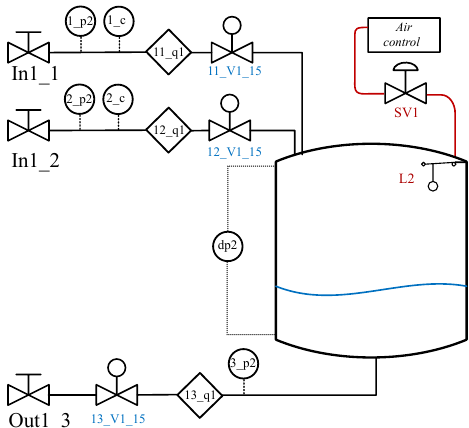
Figure A3. Piping and instrumentation diagram of the water consumer unit. The legend is shown in Figure A1 and the details for each component are listed in Table